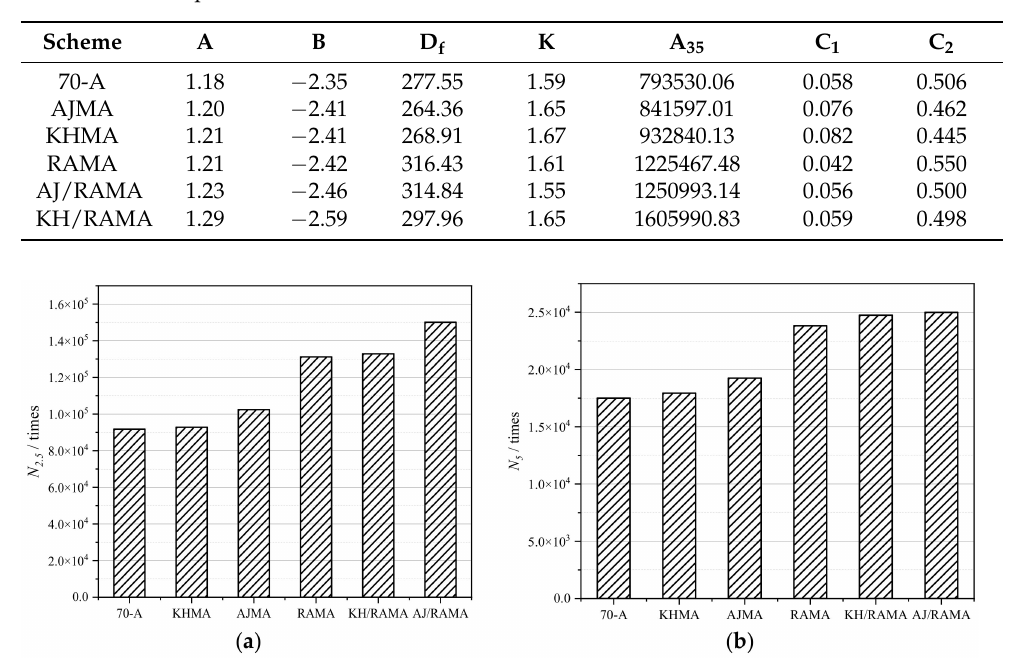
Figure 11. Fatigue life of asphalt under different strain levels: ( a ) 2.5% Strain; ( b ) 5%